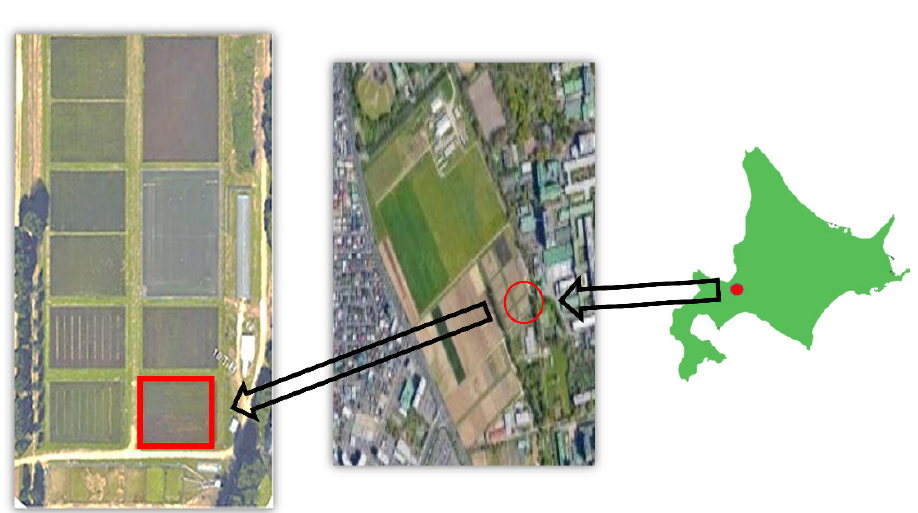
Fig. A1 Soil samples were collected in the “natural farming” rice paddy located in the